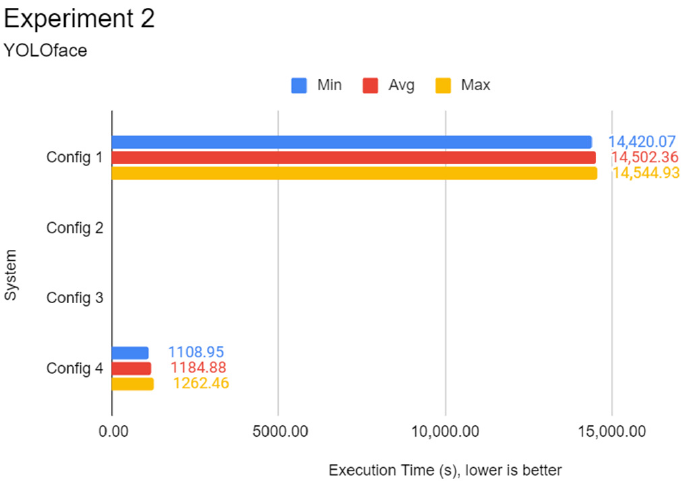
Figure A5. Bar chart execution time results for all systems running MTCNN on WIDER FACE in Experiment 2. Configurations 2 and 3 are excluded due to Spark OOM error.